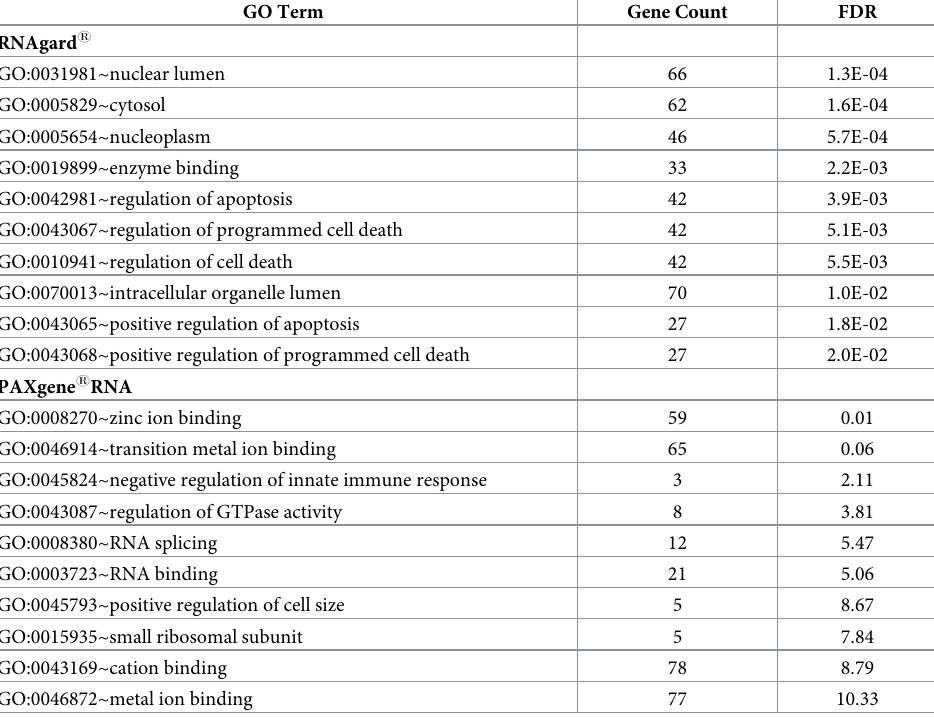
Top 10 enrichment GO terms and FDRs (False Discovery Rate) for those genes which were relatively higher (p < 0.05) in the preservation systems tested, using the DAVID annotation tool with gene count and FDR derived from the tool are listed here [11,